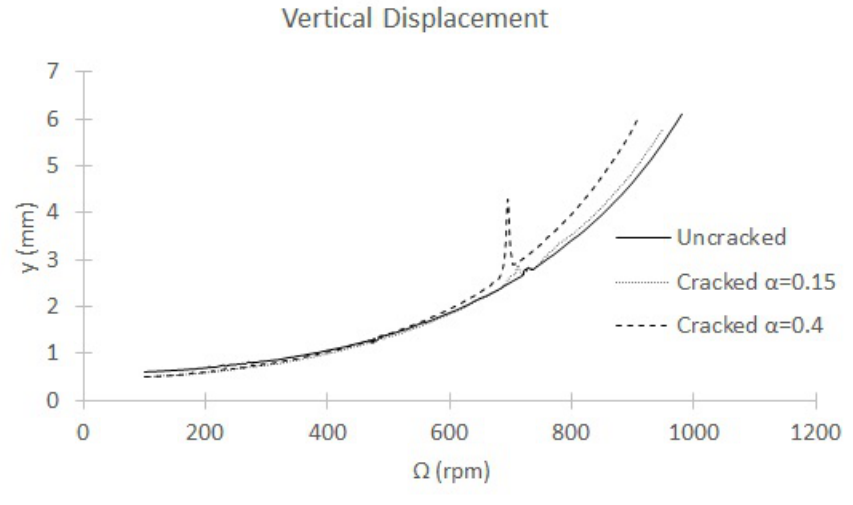
Figure 18. Vertical displacement in the speed sweep.